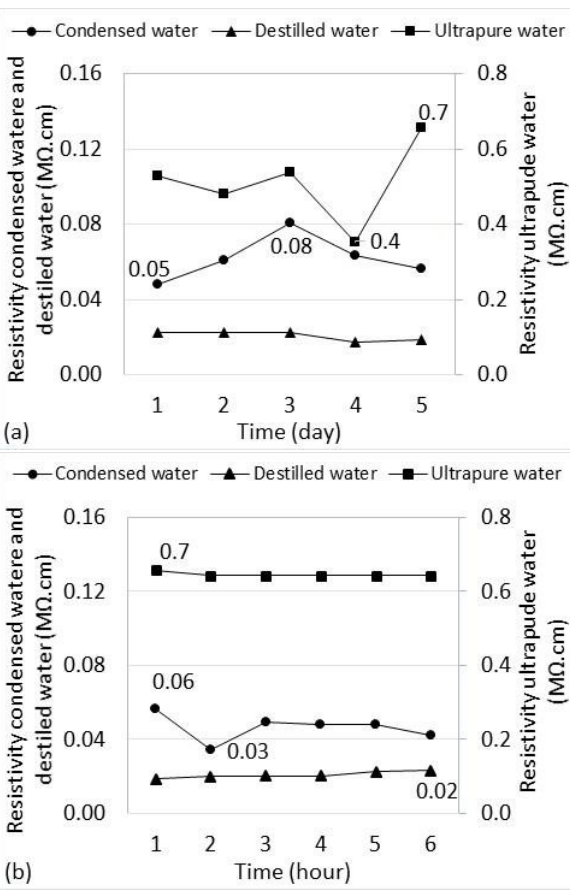
Figure 7: Resistivity values found in condensed, distilled and ultra- pure water, with daily (a) and hourly (b) monitoring.